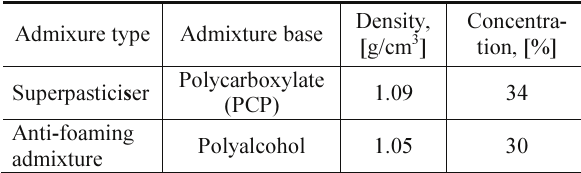
Table 9. Characteristics of admixtures